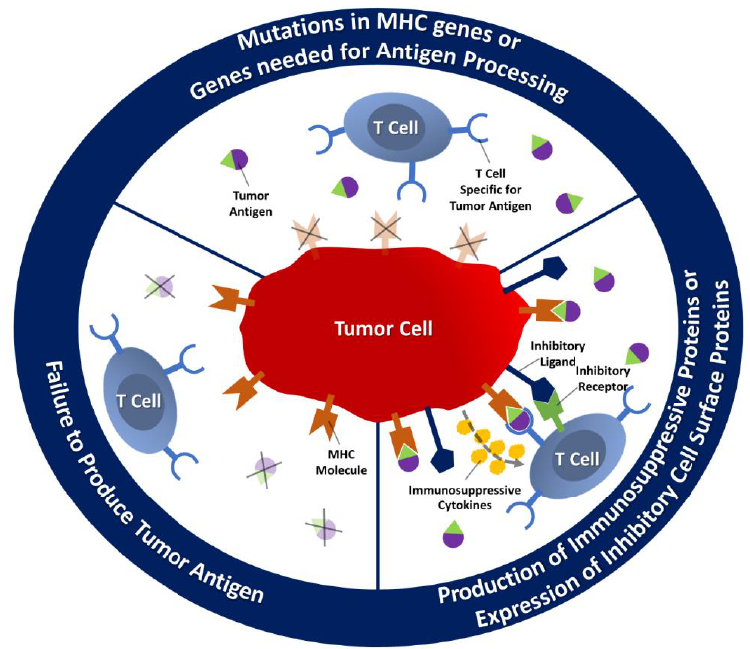
Figure 2. Mechanism of tumor escape from the immune system .